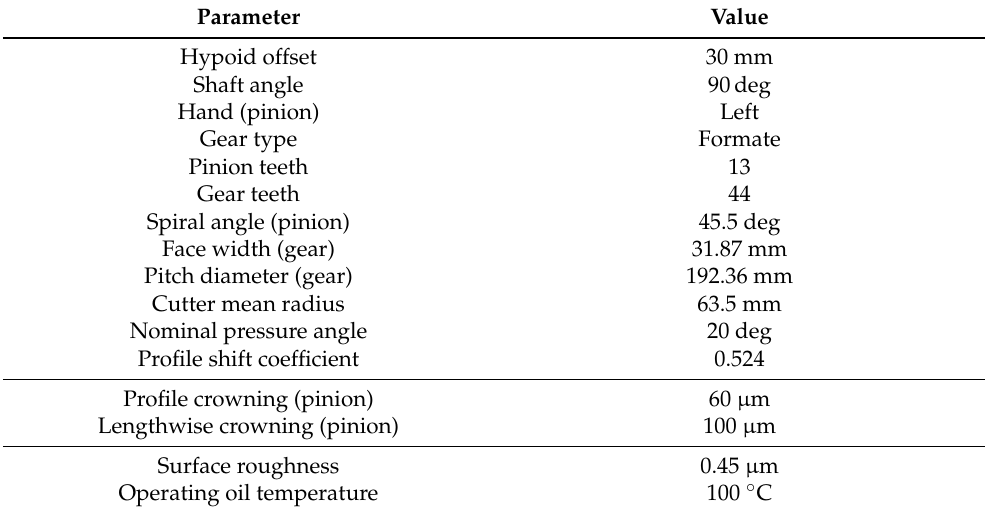
Table 2. Hypoid basic parameters.